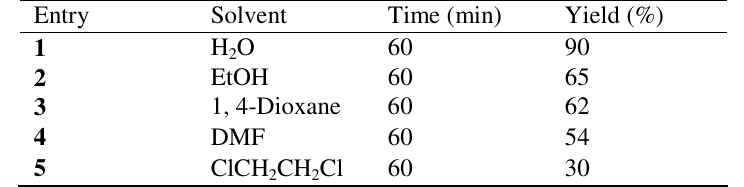
Table 1 . Solvent effect on the yields of 3a .